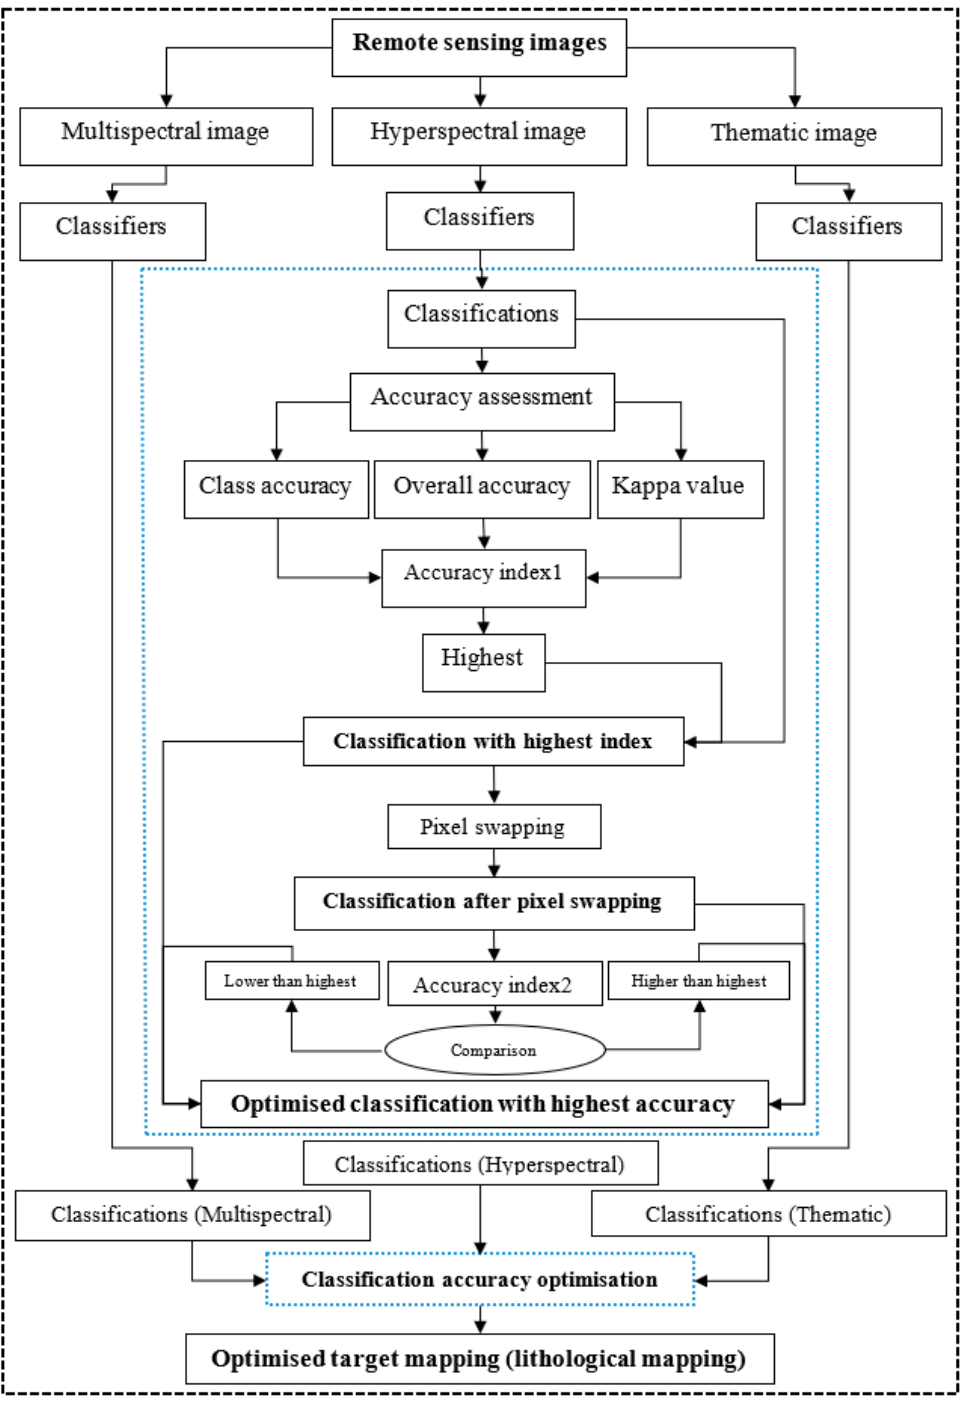
Figure 2. Flow diagram of proposed methodology for optimizing classification accuracy for lithological mapping using multi-classifiers. Note: In the procedure, the big dotted box represents the accuracy optimization process for hyperspectral data. The small dotted box represents the repetition of the process in the big dotted box, for combined classification from hyperspectral, multispectral and thematic images.